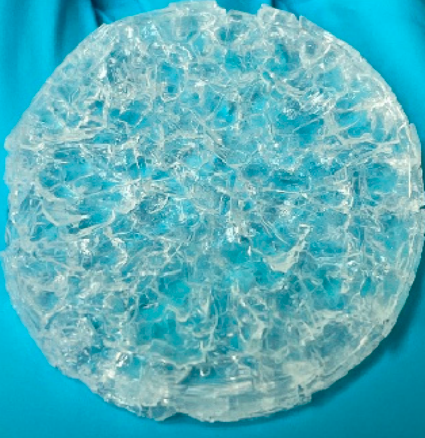
Figure 7. Poor surface quality of FC14 after 72 h of swelling at room temperature.